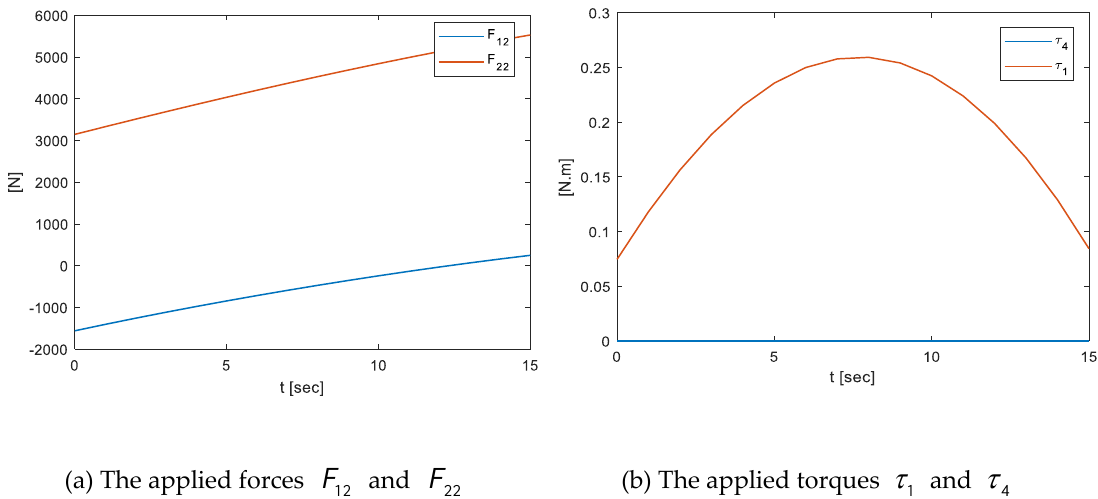
Figure 10. The forces/torques applied on the active joints.